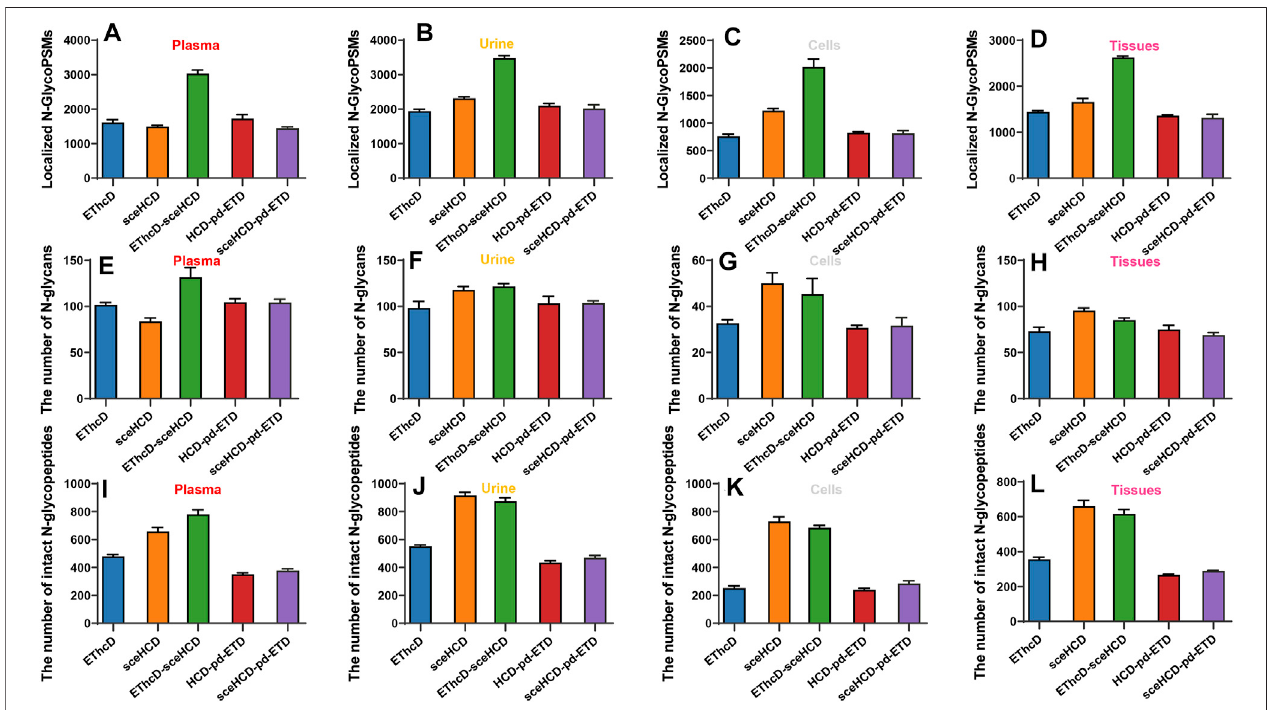
FIGURE 3 | Comparison of the number of localized N-glycopeptide spectral matches (glycoPSMs), N-glycans, and intact N-glycopeptides from human plasma, urine, cells, and tissues.